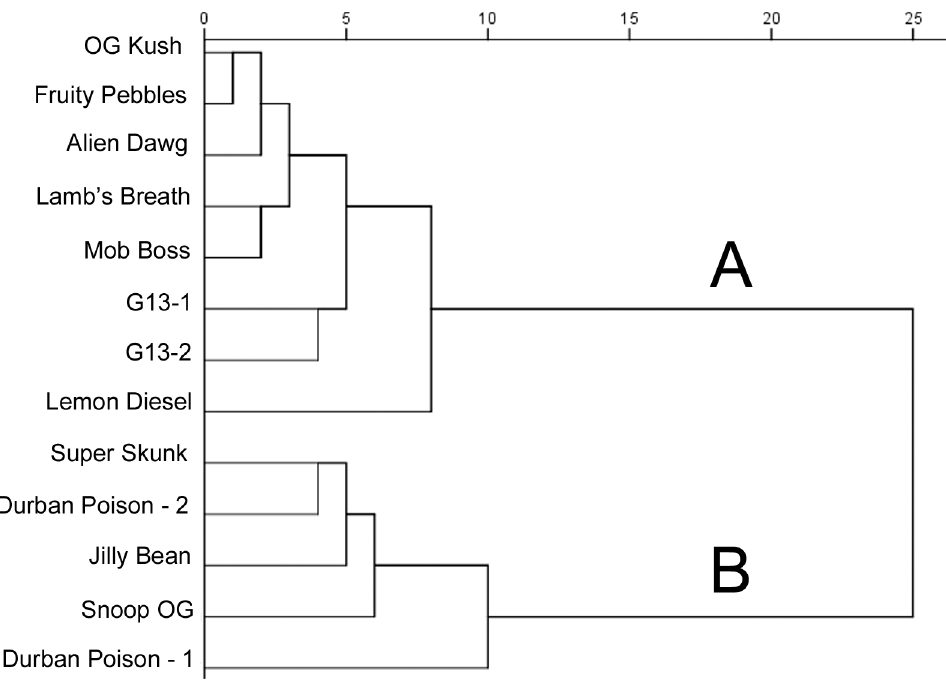
Fig 4. Hierarchical clustering analysis of all 13 cannabis samples. Distances are rescaled to 25. Samples in Cluster A were characterized as earthy , woody , and herbal ; those in Cluster B as citrus , lemon , sweet , and pungent (see text).